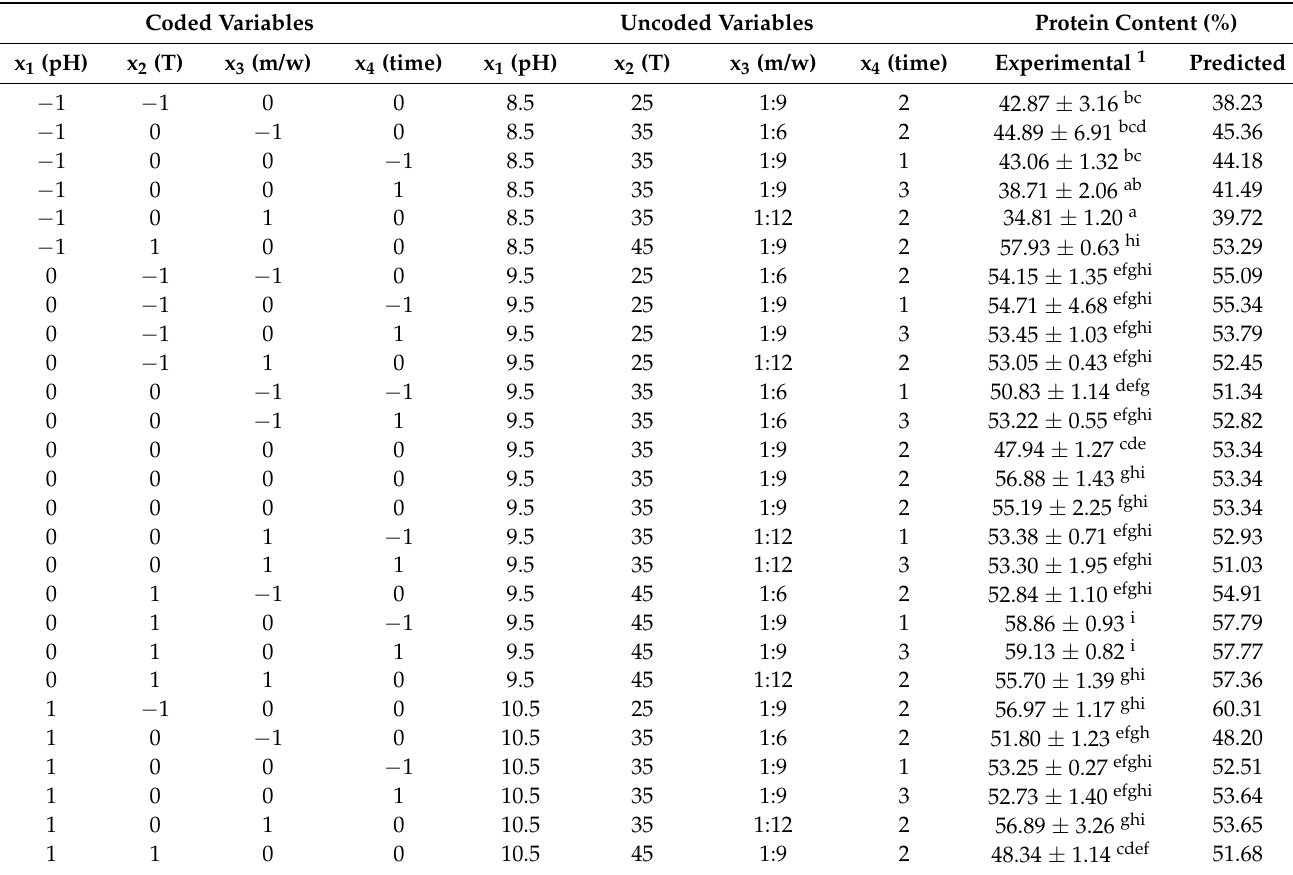
Table 2. Box–Behnken design (BBD) and responses (experimental and predicted protein contents) for the optimization of the protein concentrate extraction of defatted grape seed